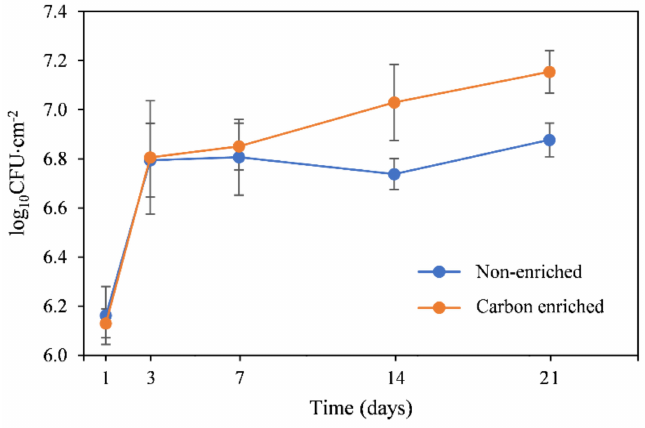
Figure 3. Biofilm growth in non-enriched medium and in medium enriched with inorganic carbon. Data are expressed as mean values of three independent replicates (error bars indicate standard